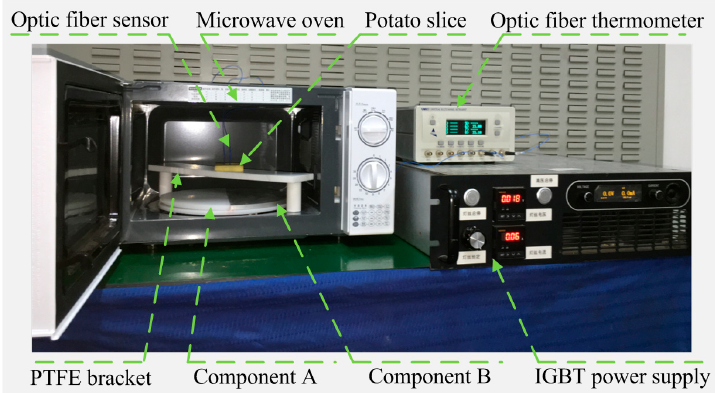
Figure 4. The photo of experimental microwave heating system.